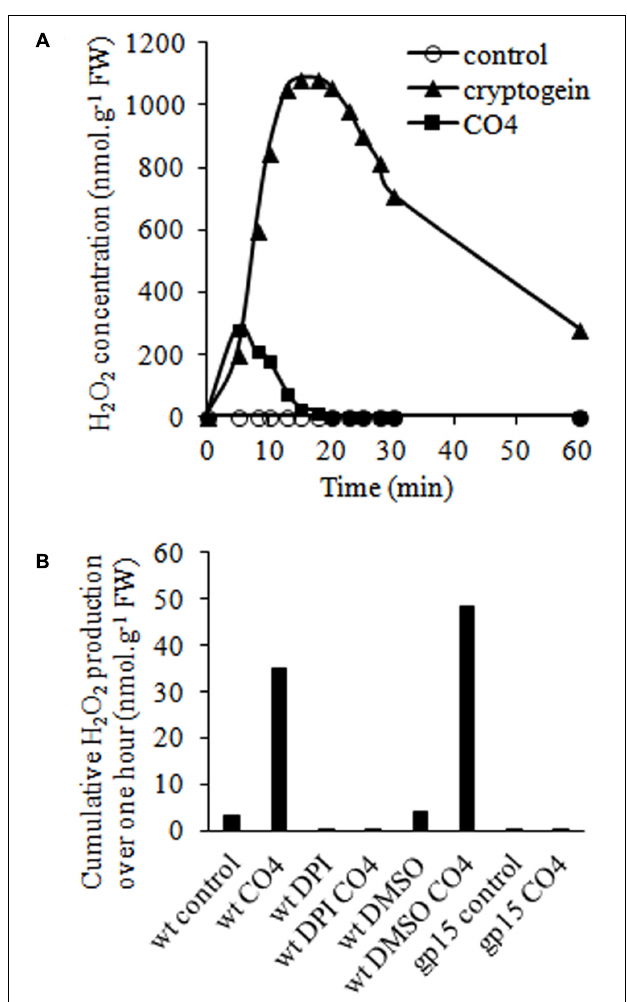
FIGURE 2 | CO4-induced H 2 O 2 production is mediated by NADPH oxidase (NtrbohD) activity in tobacco cells. (A) Time courses of H 2 O 2 accumulation in wild-type cells treated with 100 nM CO4 or 50 nM cryptogein. H 2 O 2 concentrations were measured by luminescence. Data correspond to one representative experiment out of five. Mean values ± SEs are given in Supplementary Table 2. (B) Impact of NtrbohD activity on CO4-mediated H 2 O 2 production. Wild type (wt) and NtrbohD antisense (gp15) cell lines were pre-incubated or not with 5 µ M diphenyl iodonium (DPI) before CO4 treatment. Mean cumulative H 2 0 2 production was measured for 1 h. Data correspond to one biological replicate out of